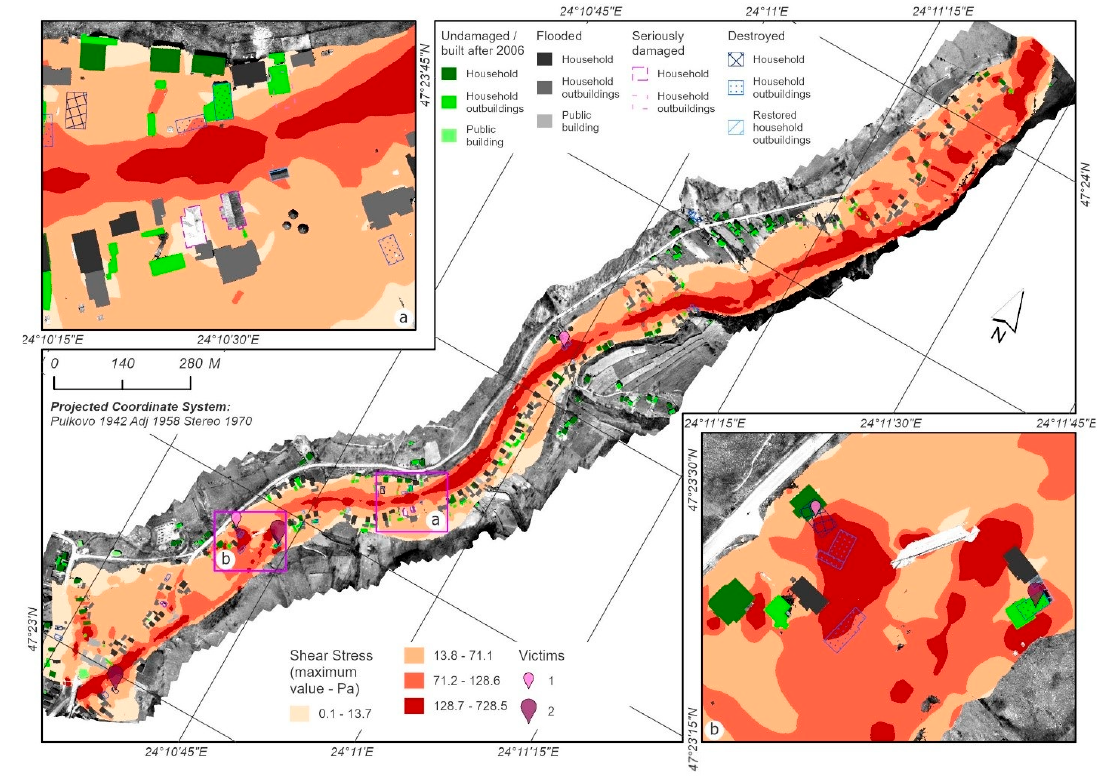
Figure 6. Shear Stress